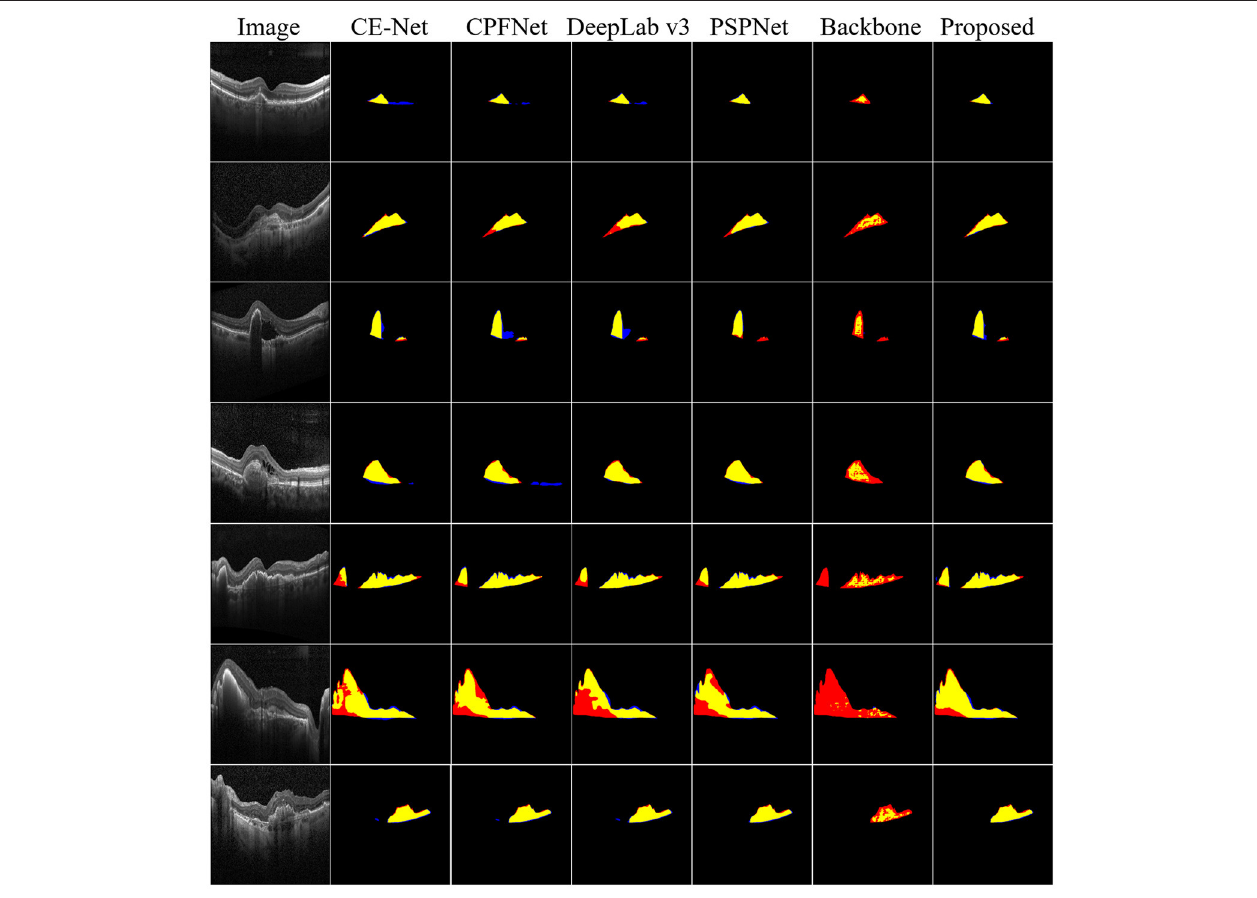
FIGURE 5 | Examples of CNV segmentation. From left to right are original image, CE-Net, CPFNet, DeepLab v3, PSPNet, backbone, and our proposed method SemiMF-Net. Yellow represents the correctly segmented region, while red and blue are the results of false-positive segmentation and false-negative segmentation, respectively.